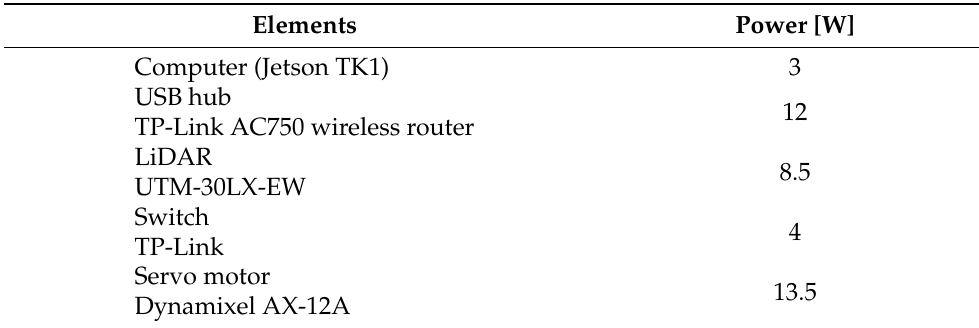
Table 3. Power consumption of control elements and